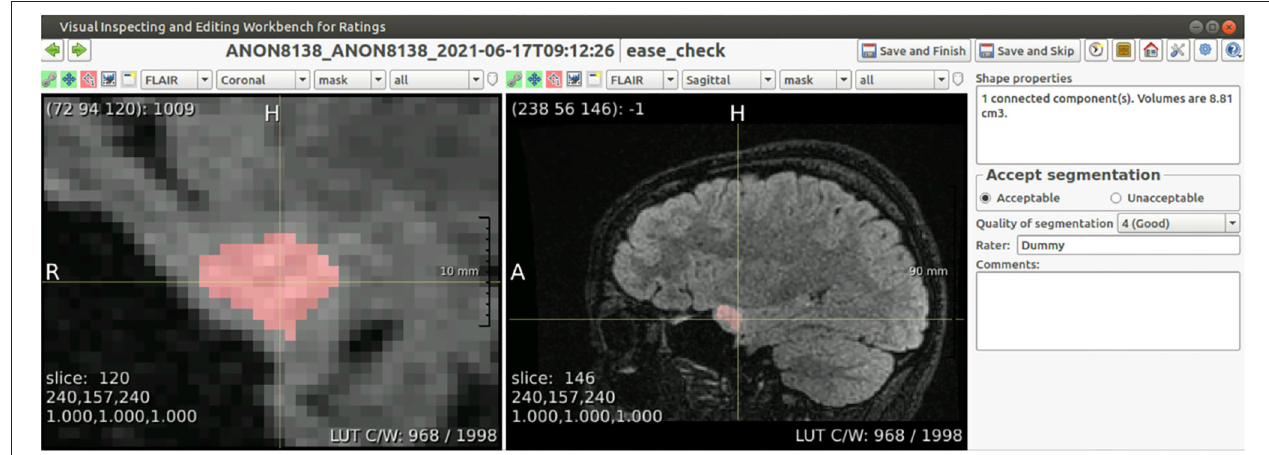
FIGURE 2 | Screenshot of the annotation interface. Both image panels can be controlled to show different scan sequences, imaging planes, to change the contrast, to zoom in or out, or to set the overlay transparency. Besides the required annotation of quality, the panel on the right shows the volume of each connected component in the segmentation, and allows for free text comments that are included in the